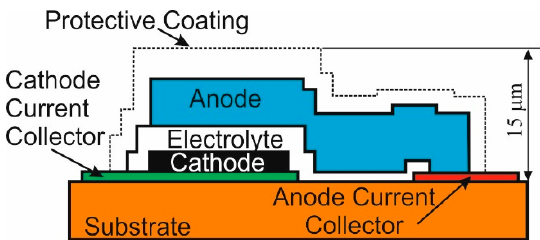
Figure 5. An example of a cross-section of a thin-film battery.